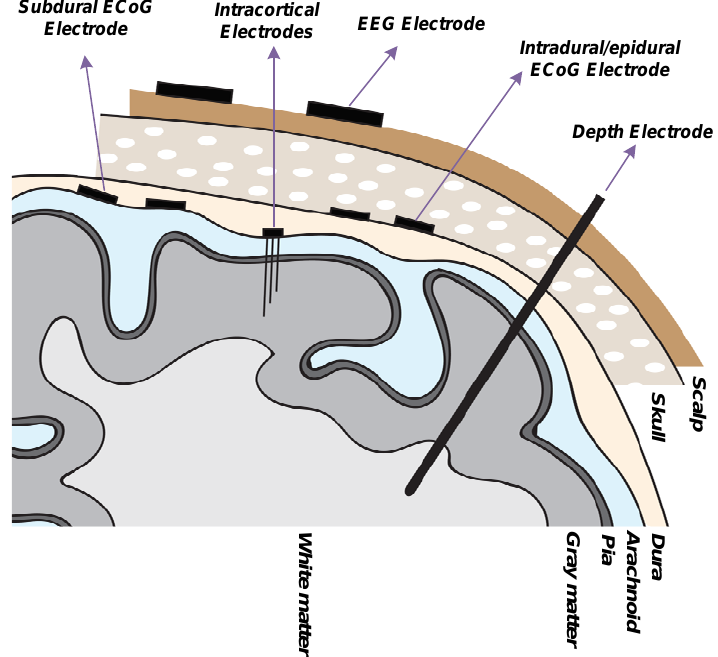
Figure 5. Simplified block diagram of a practical neural recording system.